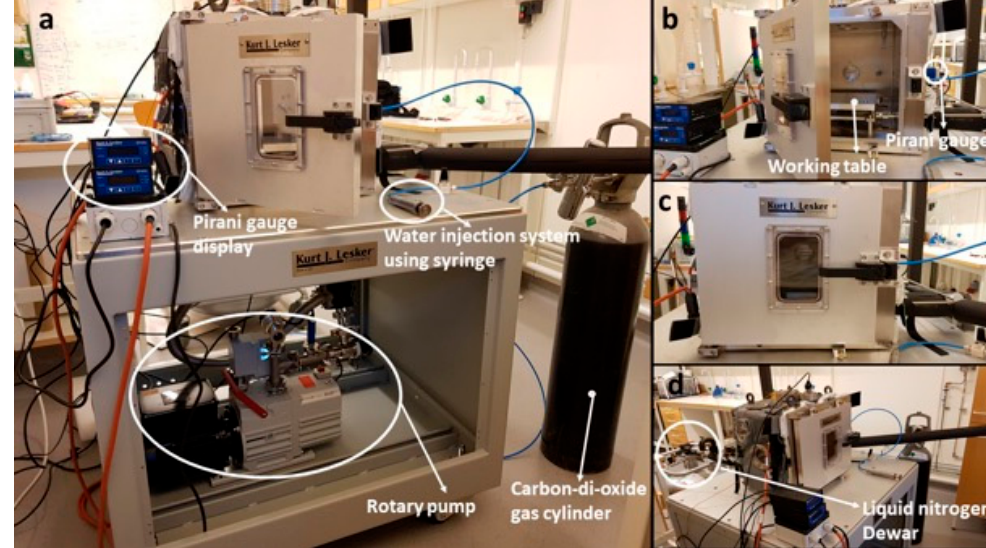
Figure 2. Overview of the SpaceQ chamber. ( a ) This figure shows the entire setup of the chamber, including the external Pirani gauge display, the rotary pump, the CO 2 gas cylinder (to insert a Mars-like atmosphere) and the syringe for water injection. ( b ) Detail of the experimental table where samples are cooled down to the desired temperature and the KJLC ® Cold Cathode/Pirani Combination Gauge on the right side. ( c ) Viewport at the front of the chamber, used to take pictures during the experiment. ( d ) LN 2 Dewar used to cool down the working table.